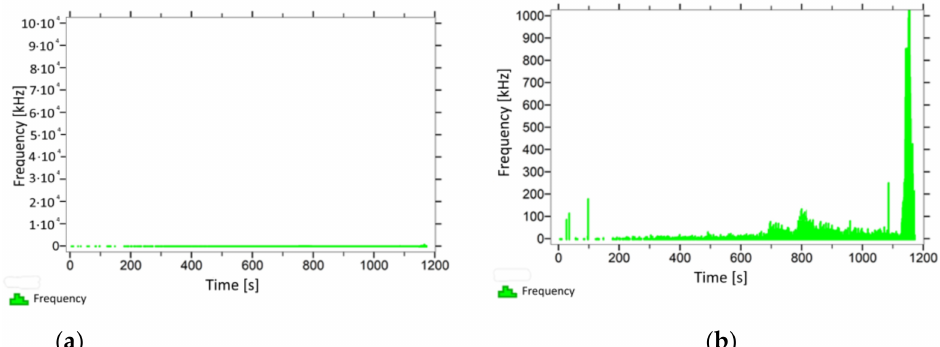
Figure 12. Graph of frequency distribution during the test for a representative sample from series P 11 : ( a ) considering the entire occurring frequency range and ( b ) with details about the frequency range before the moment of breakage.